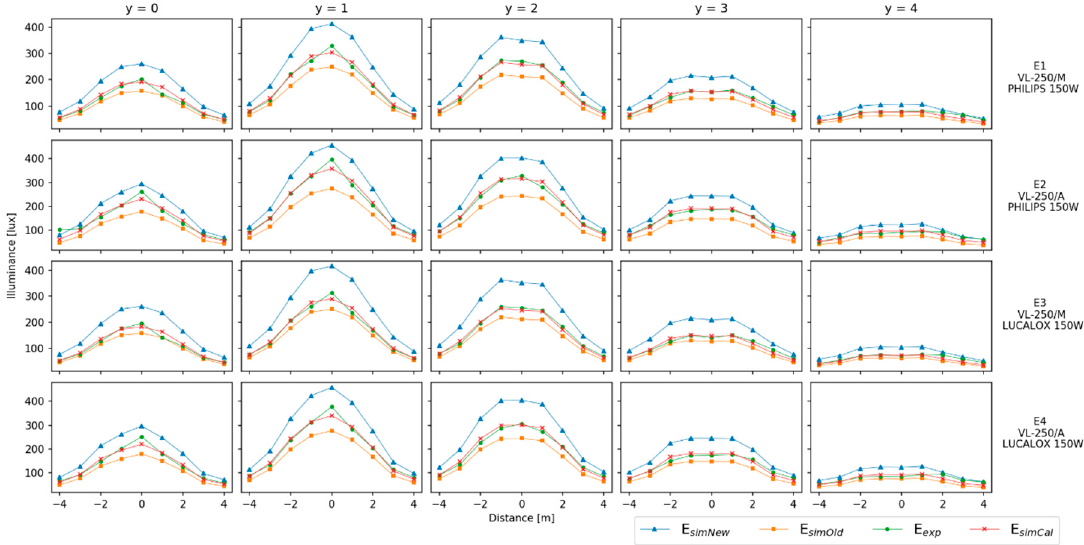
Figure 6. Illuminance in the longitudinal sections of the calculation grid considered (Figure 2) ( 𝐸 (cid:3032)(cid:3051)(cid:3043) : experimental illuminance; 𝐸 (cid:3046)(cid:3036)(cid:3040)(cid:3004)(cid:3028)(cid:3039) and 𝐸 (cid:3046)(cid:3036)(cid:3040)(cid:3016)(cid:3039)(cid:3031) : simulated illuminance after and before calibration; ( E exp : experimental illuminance; E simCal and E simOld : simulated illuminance after and before calibration; and 𝐸 (cid:3046)(cid:3036)(cid:3040)(cid:3015)(cid:3032)(cid:3050) : simulated illuminance supposing that the lamps are newly installed). and E simNew : simulated illuminance supposing that the lamps are newly